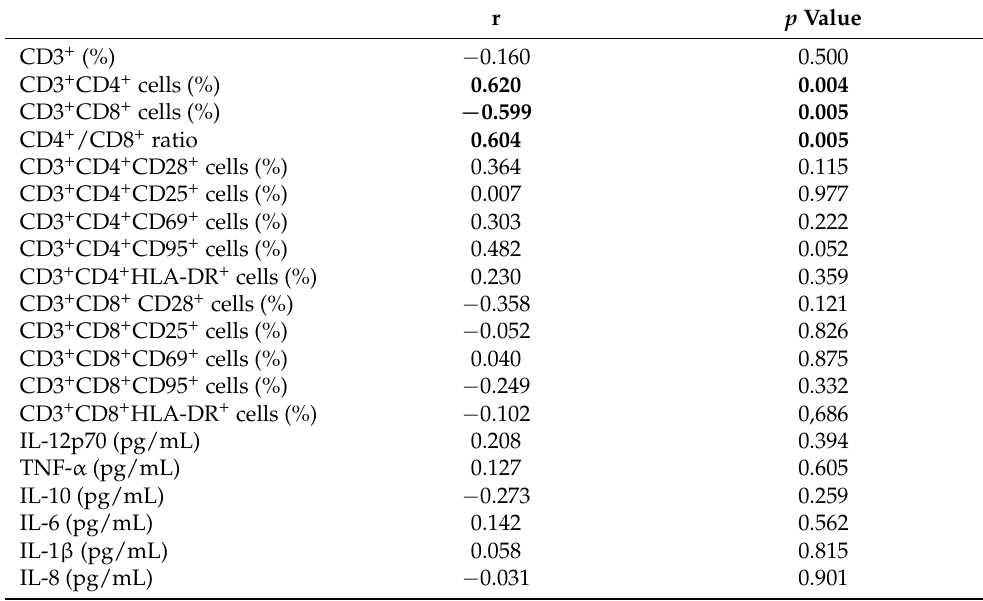
Table 3. Correlations between current episode length and immune parameters.